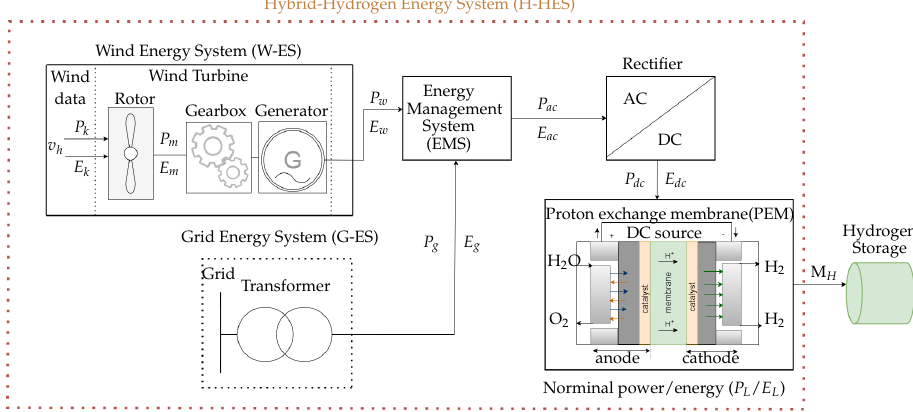
Figure 1. Hybrid-hydrogen energy